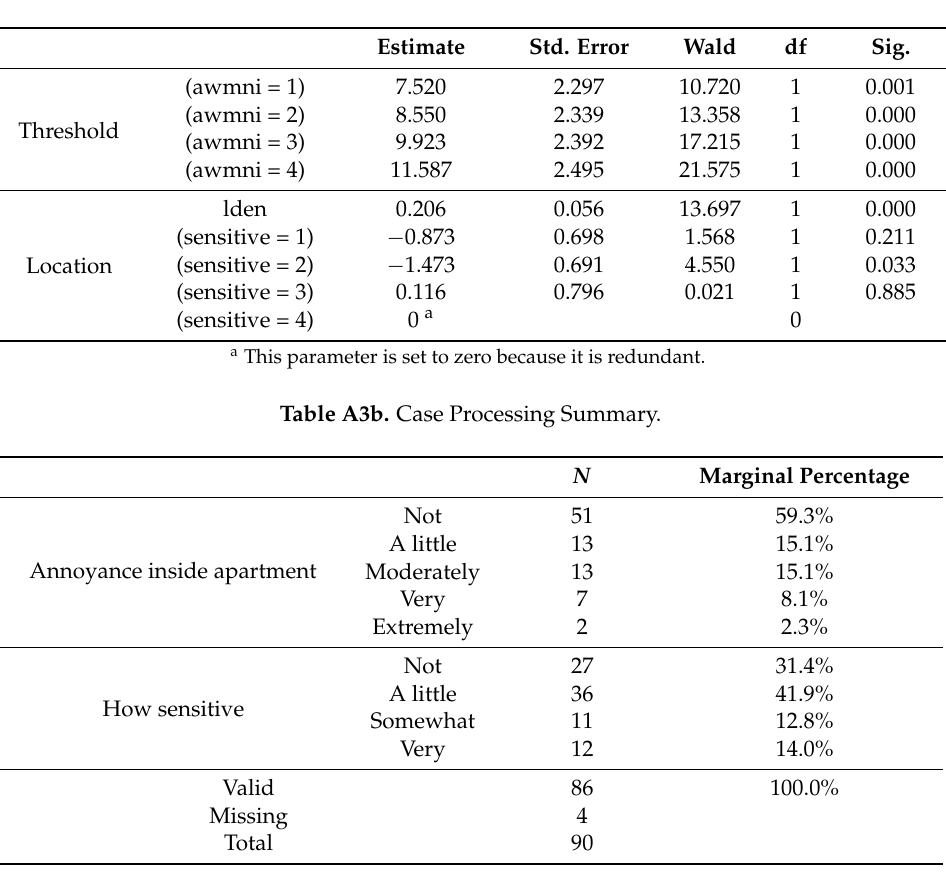
Table A3a. Estimated parameters of the relationship between noise exposure (L den ) and indoor wind turbine noise annoyance with control for noise sensitivity. N = 87.